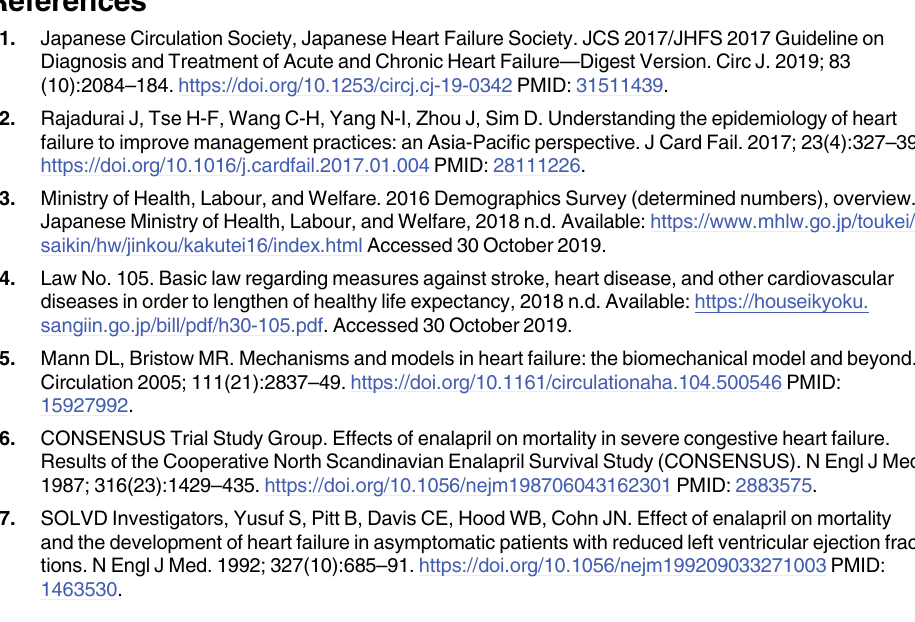
S1 Table. Patient characteristics of the entire cohort. S2 Table. Associations between patient characteristics and ACEI/ARB. S3 Table. Associations between patient characteristics and β -Blocker. S4 Table. Associations between patient characteristics and